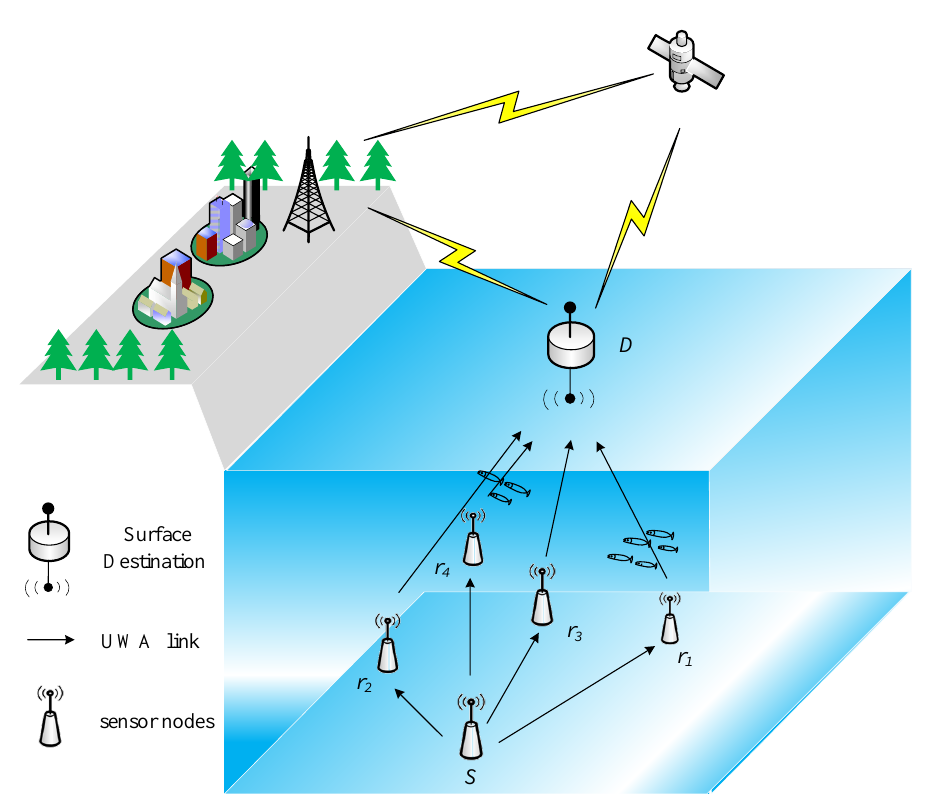
Figure 3. An UWA cooperative network